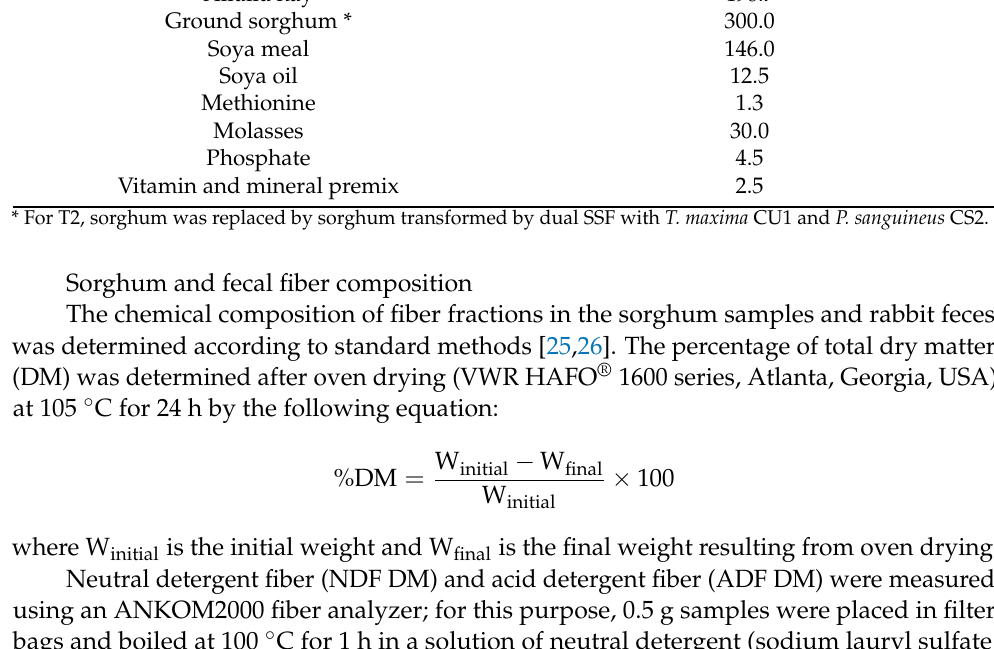
Table 1. Experimental diet composition.